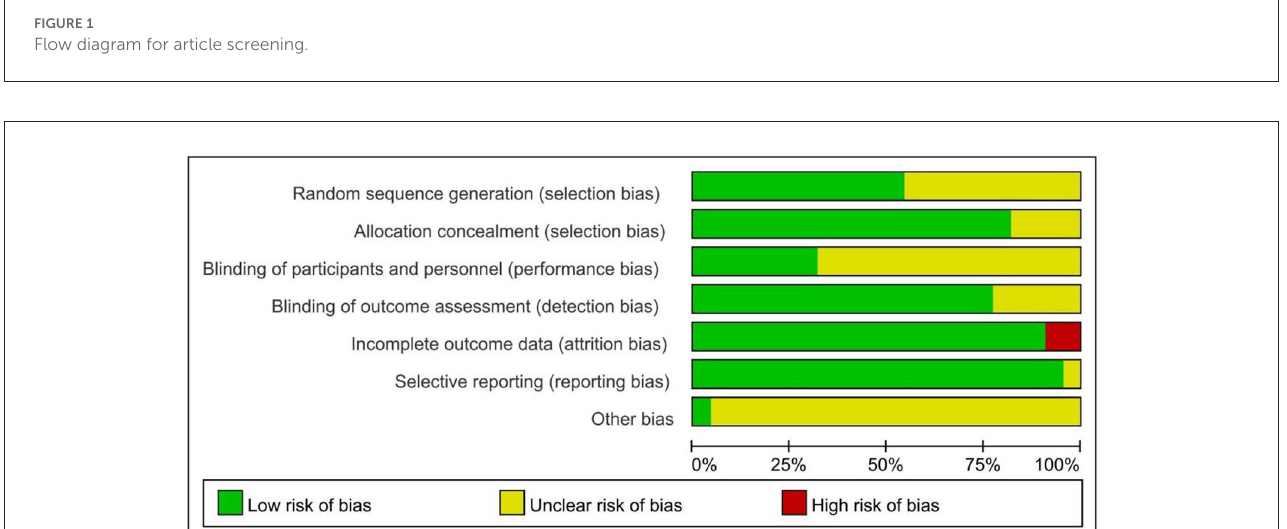
FIGURE2 Quality assessment of the risk of bias of included studies.